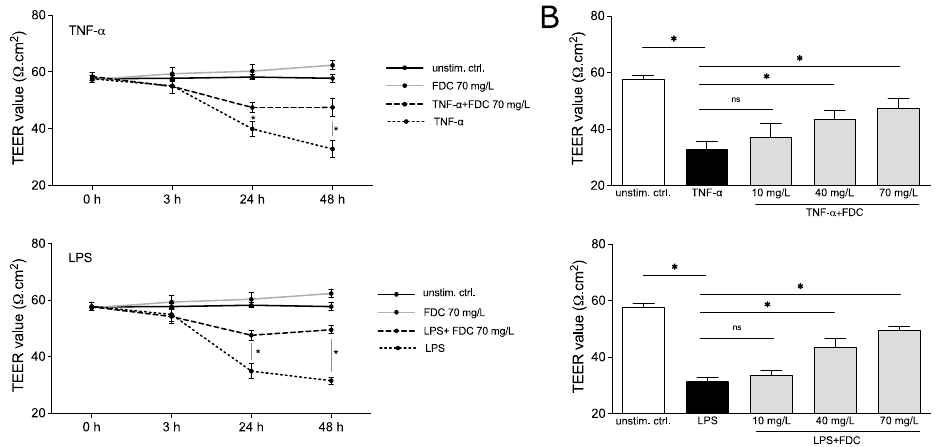
Figure 2. Cefiderocol dampens LPS and TNF- α induced decrease in endothelial cell integrity. HUVEC/edWB coculture was stimulated with 100 ng/mL LPS or 100 ng/mL TNF- α with or without cefiderocol (concentrations: ( A ): 70 mg/L, ( B ): 10 mg/L, 40 mg/L, 70 mg/L). TEER was measured with the EVOM3 volt/ohmmeter (timepoints: ( A ): after 0 h, 3 h, 24 h and 48 h, ( B ): after 48 h). Shown are mean and standard deviation of three biological replicates ( n = 3). Statistical significance was calculated using a one-sided Mann–Whitney U test ( p < 0.05 = * and was considered statistically significant, ns = statistically not significant). Abbreviations: TEER = transendothelial electrical resistance, FDC = cefiderocol, TNF- α = tumor necrosis factor- α , LPS = lipopolysaccharide.